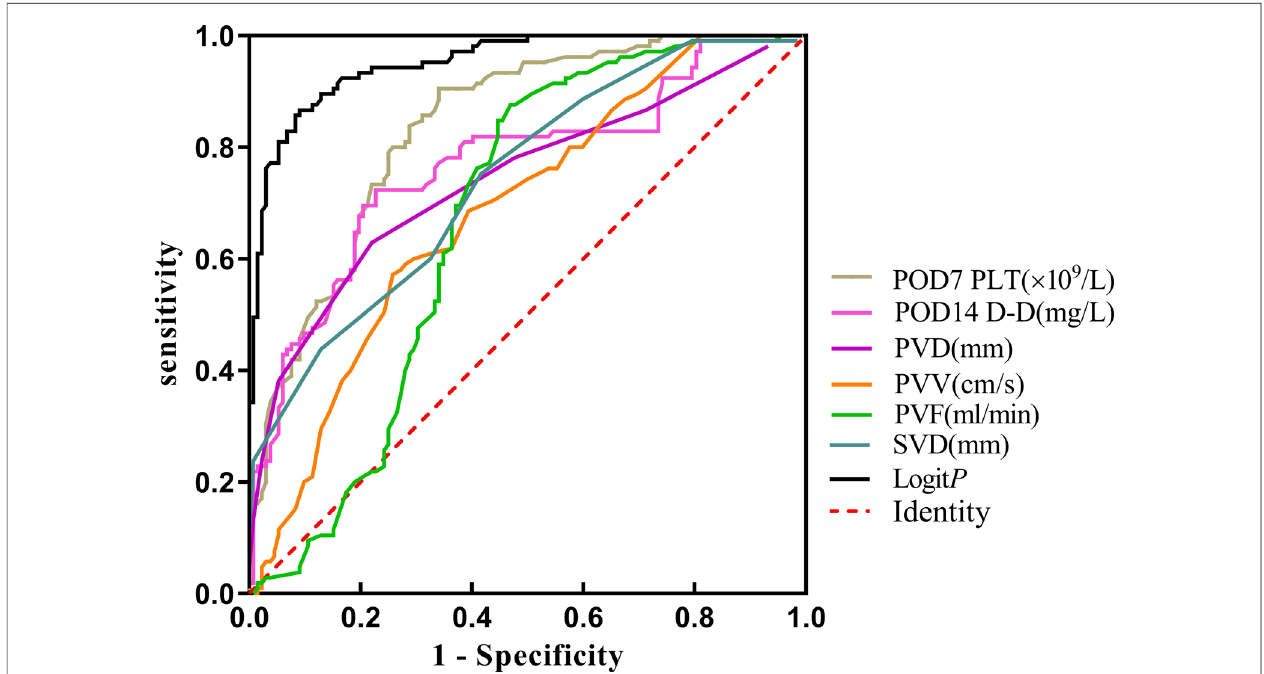
FIGURE 5 | The ROC curve of the PVST predictor after splenectomy for Wilson ’ s disease cirrhosis with portal hypertension. PVD, portal vein diameter; PVV, portal vein velocity; PVF, portal vein fl ow; SVD, splenic vein diameter; POD, postoperative day. Logit P: combined prediction of PVST based on meaningful factor.